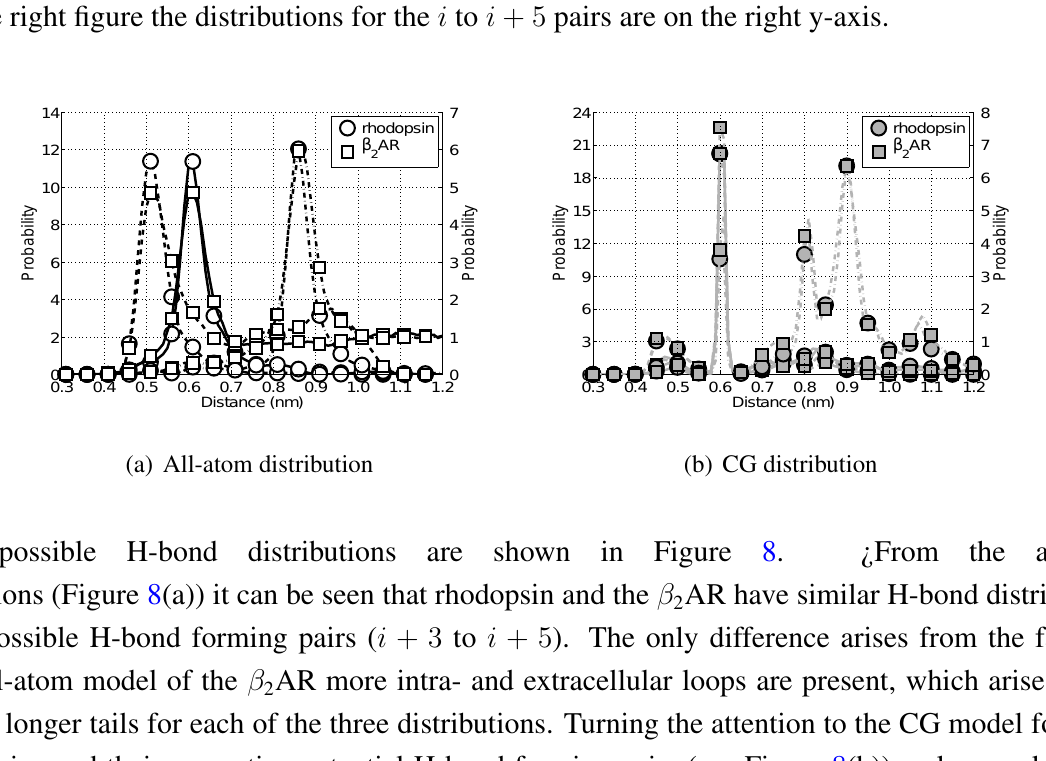
Figure 8. Distributions of potential H-bond forming pairs in the all-atom simulations (on the left) and in the CG simulations (on the right). For the possible H-bond forming pairs of rhodopsin and the β AR backbone particles along the chain are considered, where the 2 dashed lines indicate i to i + 3 pairs, solid lines i to i + 4 pairs, and dash-dotted lines i to i + 5 pairs. In the left figure the distribution for β AR is put on the right y-axis, whereas in 2 the right figure the distributions for the i to i + 5 pairs are on the right